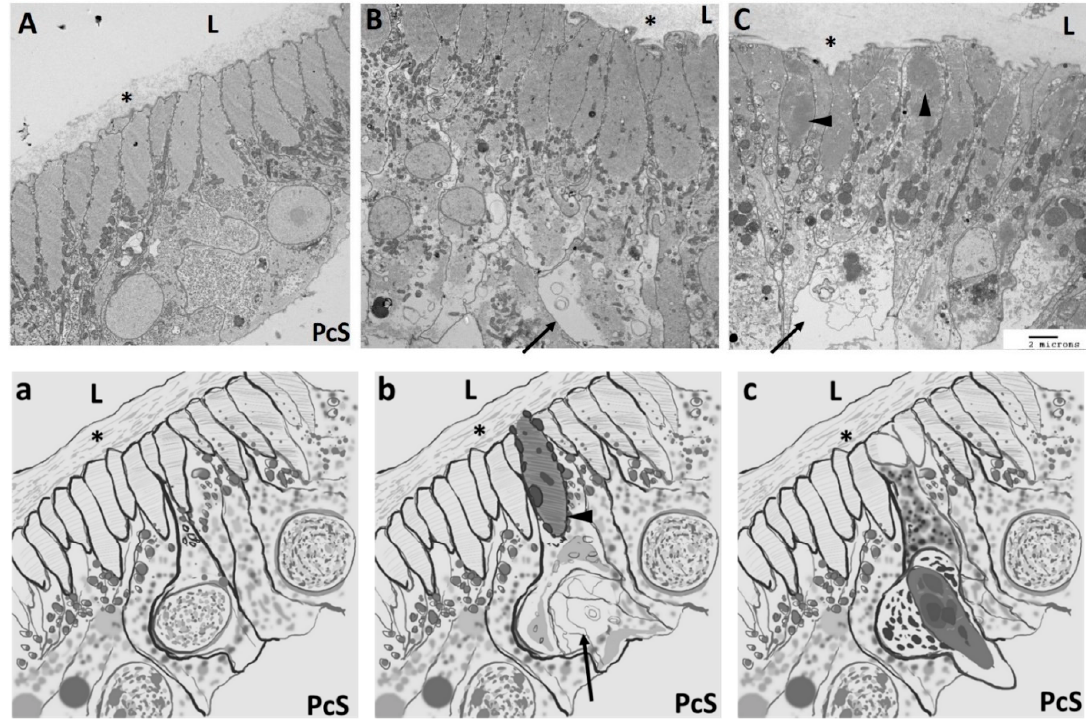
Figure 6. Degeneration of cardiac myocytes. Panels ( A )–( C ) are transmission electron micrographs of Ciona myocardium and panels ( a )–( c ) are cartoon depictions of the TEM images to highlight details and provide a proposed model for cardiac myocyte degeneration. ( A ) Normal Ciona myocardium displays cardiac myocytes with organized myofibrils and thin layer of extracellular matrix on the luminal side (asterisk); ( B ) 24 h post stress, myofibrils in cardiac myocytes begin to break down, spaces open toward the pericardial space (PcS, arrows), mitochondria migrate toward both poles and enlarge, and the extracellular matrix in the lumen thickens (asterisk); and ( C ) 48 h post stress, complete breakdown of the myofibrils occurs (arrow heads).